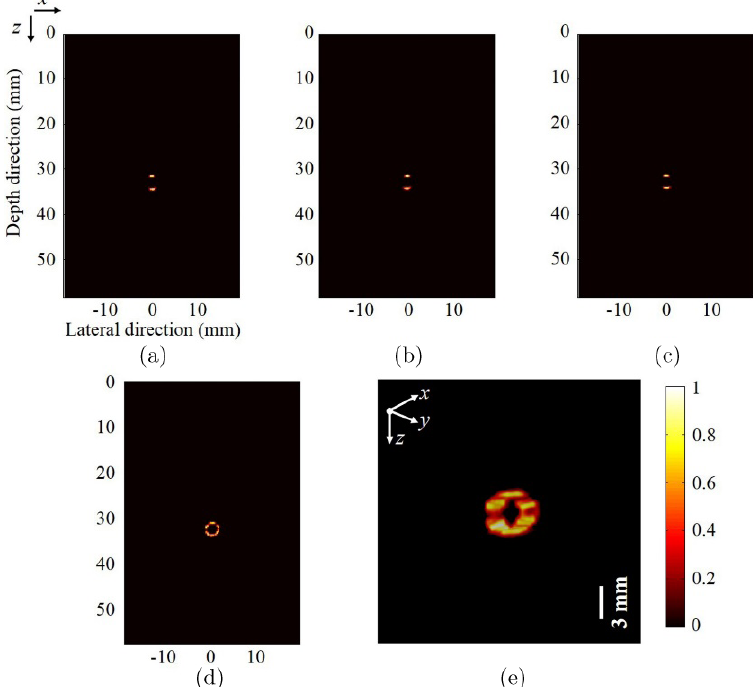
Fig. 8. Synthetic aperture PAT experiment results of limited-view compensation. (a) – (c) PA images of the rotated phantom at orientations of (cid:2) 60 (cid:1) , 0 (cid:1) , and 60 (cid:1) , respectively. (d) PA image reconstructed by the synthetic aperture in the cross-section. (e) Three- dimensional PA image of the